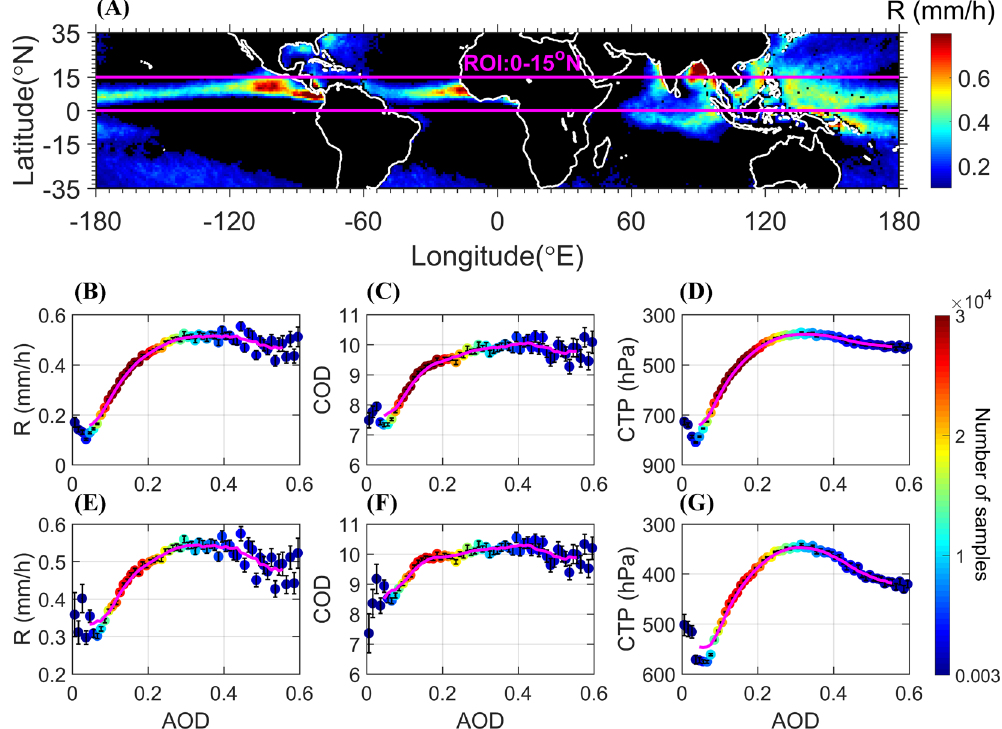
Figure 1. Map of the average R and associated plots of cloud properties as a function of the AOD (bin size of 0.01) at 1330 local time in JJA (2003–2012). ( A ) Average R for all days with AOD ≤ 0.6. The magenta lines mark the ROI. ( B – G ) For days with R > 0, and AOD ≤ 0.6 ( B ) R, ( C ) COD, and ( D ) CTP, while ( E ) R, ( F ) COD, and ( G ) CTP for days with R > 0, AOD ≤ 0.6, and CF ≥ 0.7. The colors denote the number of samples, the error bars represent the standard error, and the magenta curves are the corresponding 9-point moving